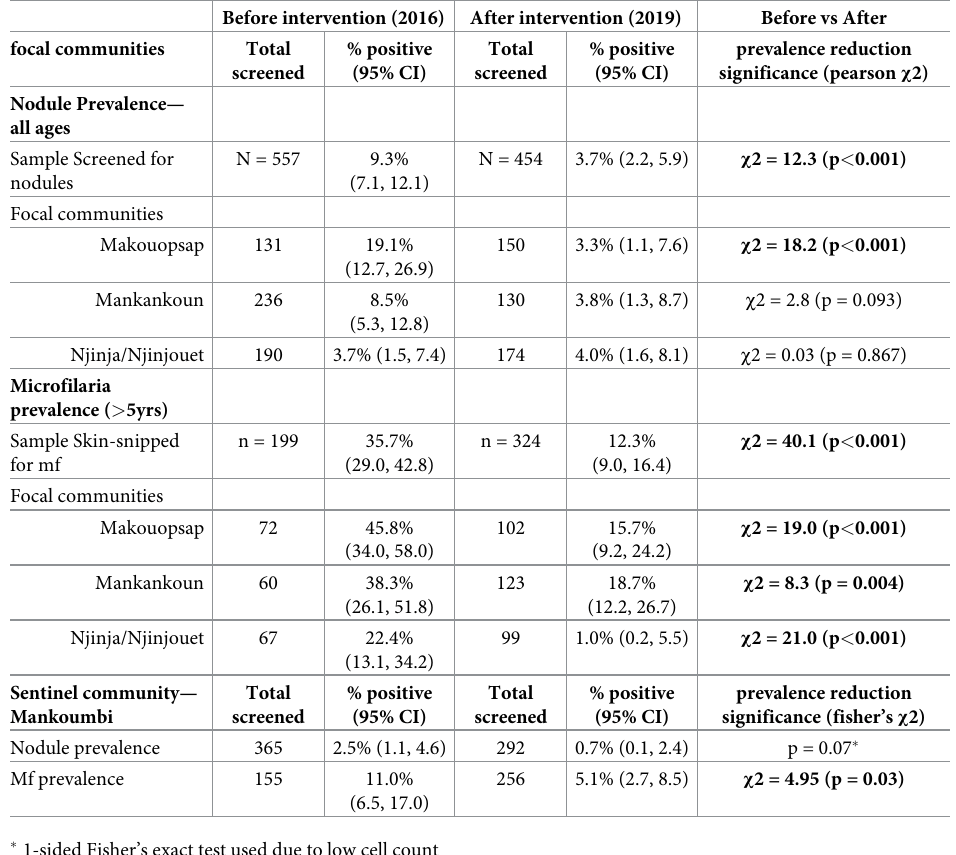
Before intervention (2016) After intervention (2019) Before vs After % positive screened (95% CI)